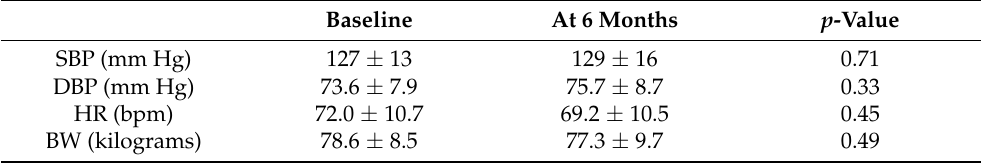
Table 1. Characteristics of the patients at baseline and after 6 months of treatment with tadalafil. Baseline